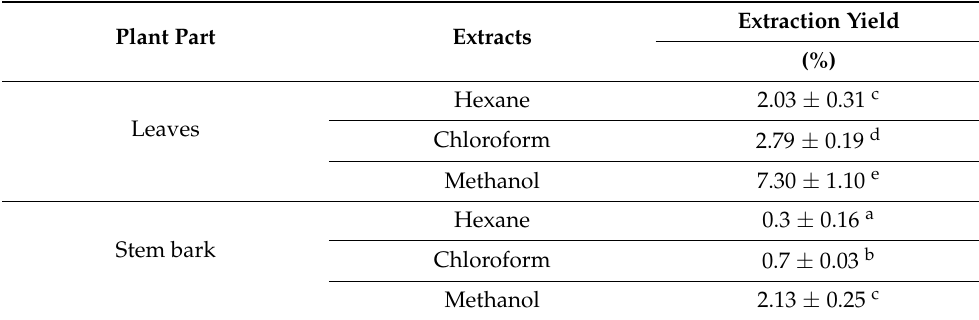
Table 1. The extraction yield of various M. glabra